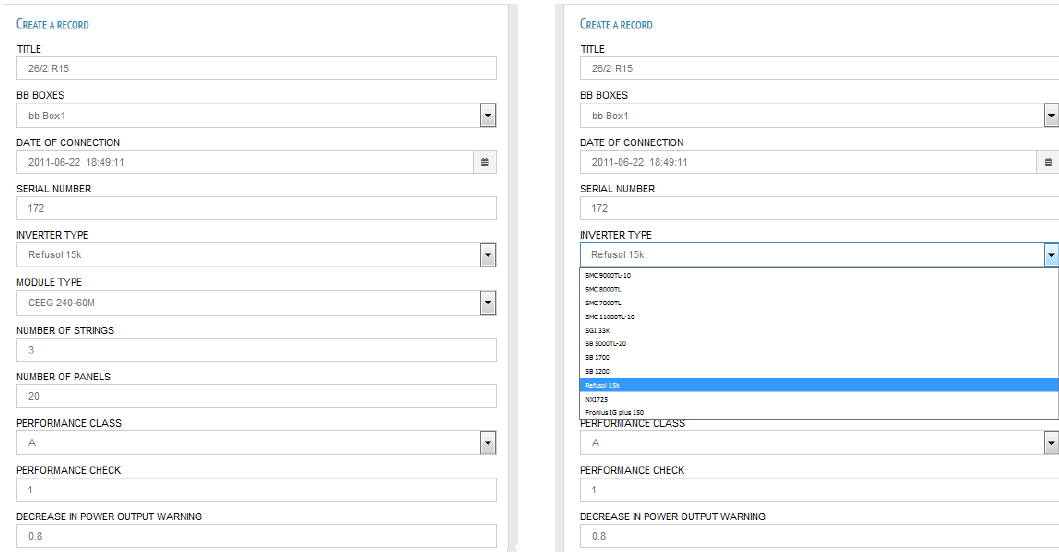
Figure 2. Service interface of the monitoring system Solarmon-2.0.